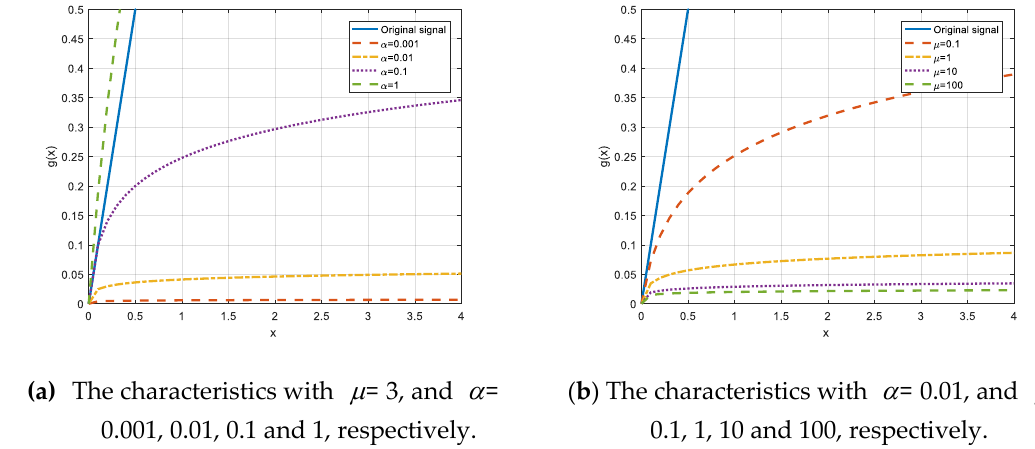
µ law algorithm with di ff erent